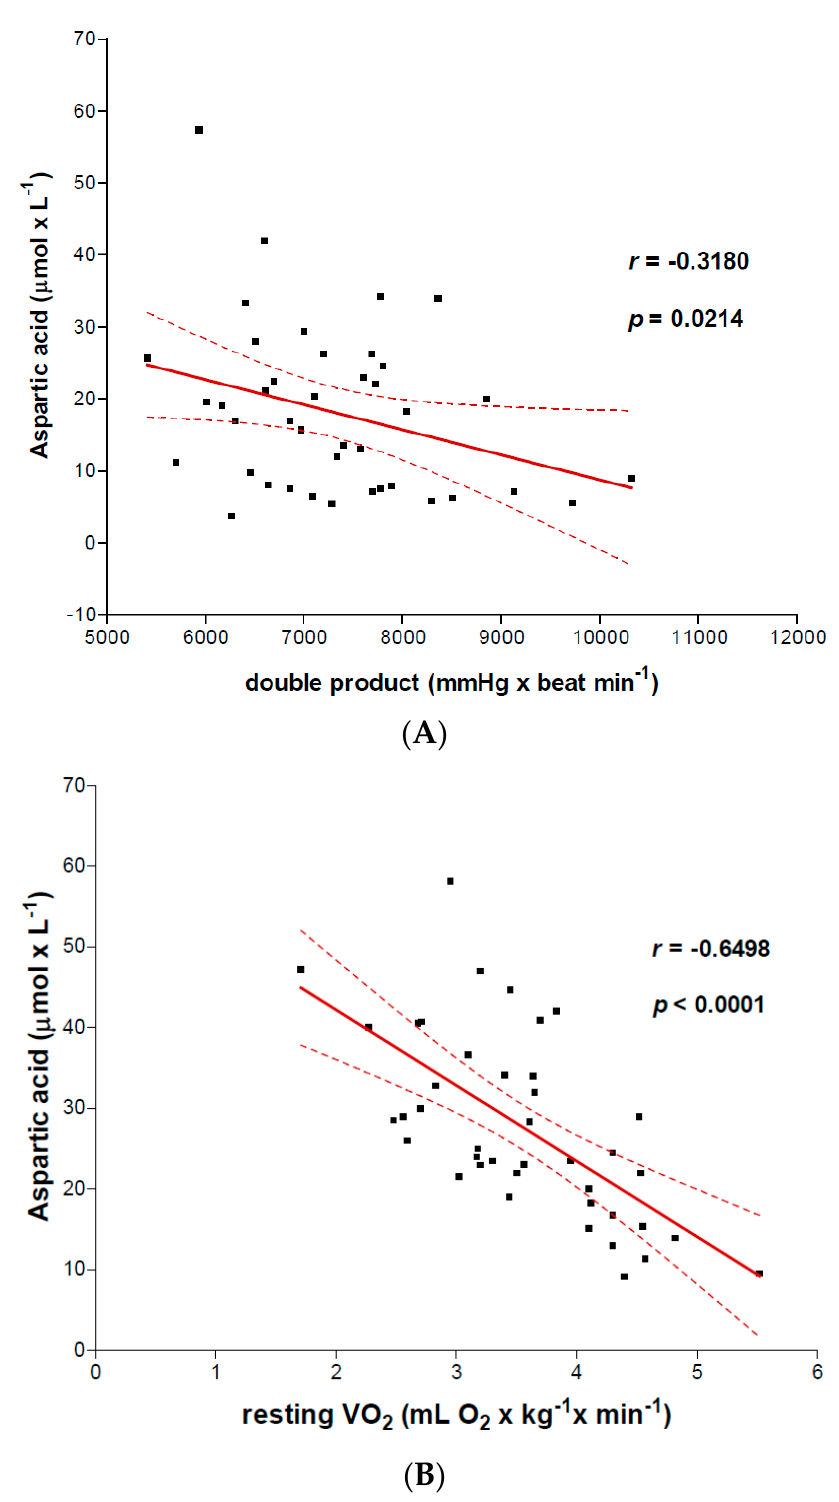
Figure 2. Negative correlation between arterial Aspartic acid levels and hemodynamic parameters. Arterial Aspartic acid negatively correlates with Double Product ( panel A ) and body resting VO 2 ( panel B ).